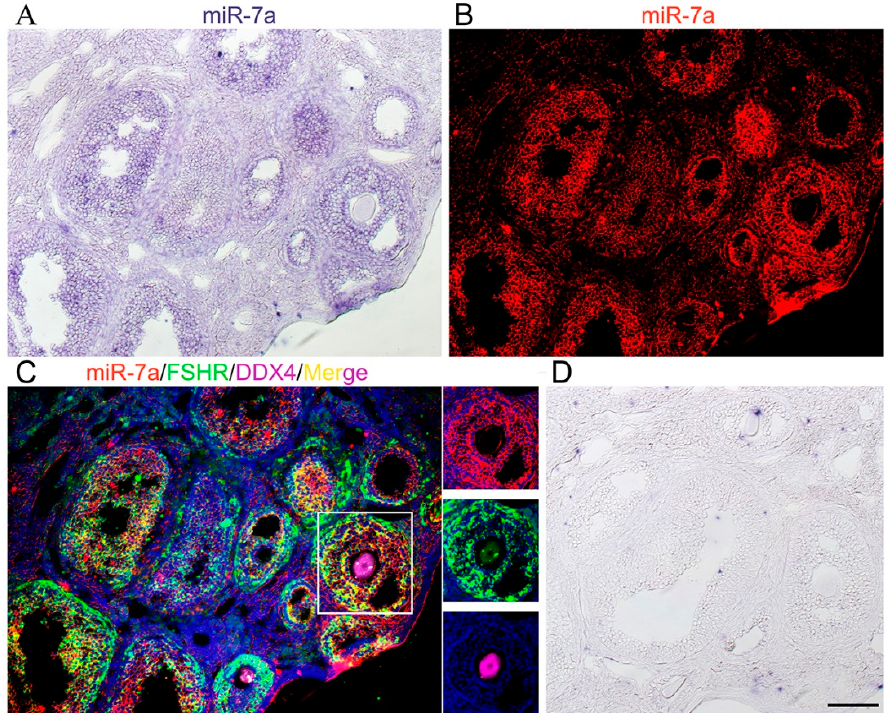
Figure 1. Expression of miR-7a in the mouse ovary.( A ) The expression of miR-7a in the ovaries of mice at 6–8 weeks of age was detected by the ISH method. ( B ) miR-7a was adjusted from purple/ blue to red fluorescence. ( C )Triple -immunofluorescence of adult mice ovary sections: miR-7a (red), FSHR (green), DDX4 (pink), and DAPI (blue); yellow is the merge of red and green. ( D ) The negative control of ( A ). Bars: 50 μ m.